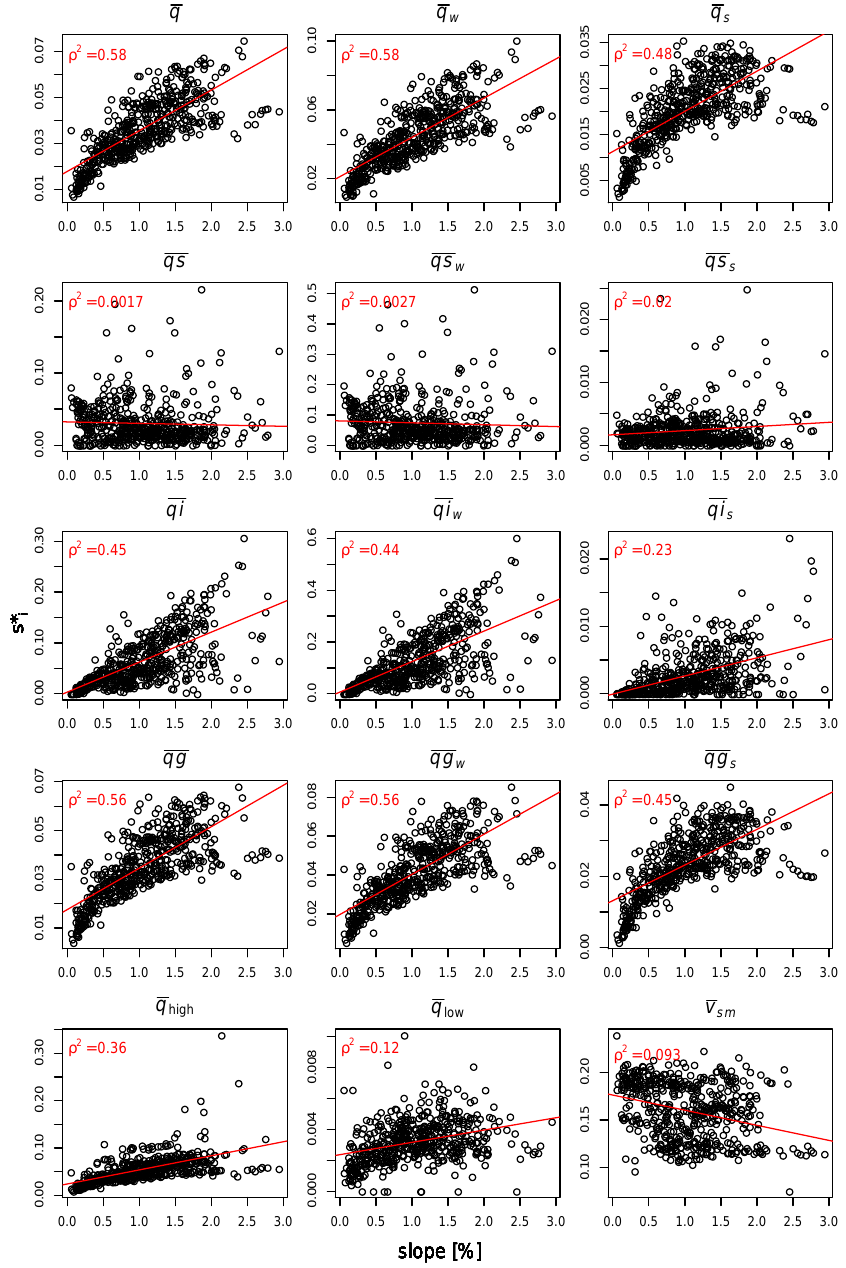
Figure 9. Relation between the slope and spatial sensitivity analysis results ( (cid:63) s i ) quantified with different response functions. Explanation of the response functions is presented in Table